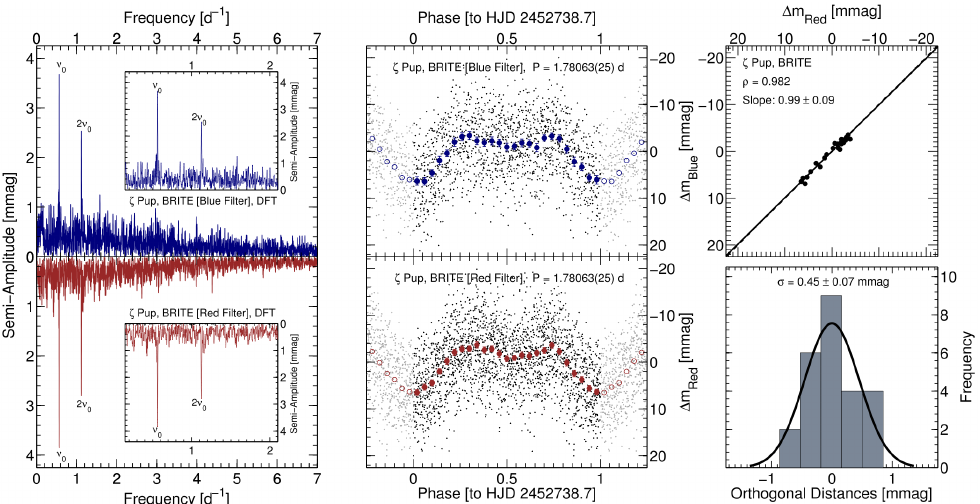
Figure 5. Analysis of the 2014–2015 BRITE light curves of ζ Pup in two optical filters (Figure 5 in Ramiaramanantsoa et al. 2018 [24]). Left panels: Discrete Fourier Transforms of the blue and red (upside down for convenience) light curves, showing the only two frequencies detected: the fundamental one (at ν 0 , corresponding to P = 1.78 d) and its first harmonic (at 2 ν 0 ), a result of the two peaks in the light curves. Central panels: The phased light curves with the original data along with binned data. Right panels: Upper: The binned data plotted for one against the other filter, showing their identical nature (both filters are too far to the red from the Planck peak emission to be sensitive to temperature differences). Lower: Dispersion perpendicular to the straight-line in the above plot, showing that it is mostly instrumental due to Poisson noise, thus in line with the identical nature of the variations in the blue and red optical filters. The same result occurs for the unbinned